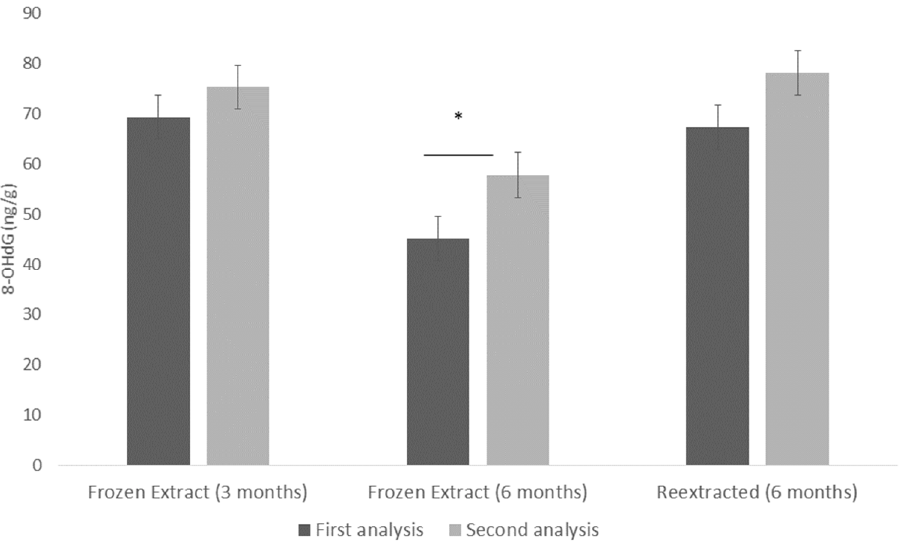
Figure 5. Changes in mean ± SE sample concentrations of fecal oxidized guanine (8-OHdG) measured under different storage conditions in grizzly bear samples. The first two pairs on the graph show changes in concentrations (n = 4 for each) after samples were extracted and analyzed, and the extract was then stored at − 20 °C for three or six months and reanalyzed. The final pair shows the effects of re-extracting dried, pulverized fecal samples (n = 3) that had been stored at − 20 °C for six months prior to re-analysis. Concentrations are expressed as ng/g dry feces. Standard error bars were calculated by taking the standard deviation of each individual sample at both time points, averaging those, and then calculating the standard error within each comparison. * p < 0.05.